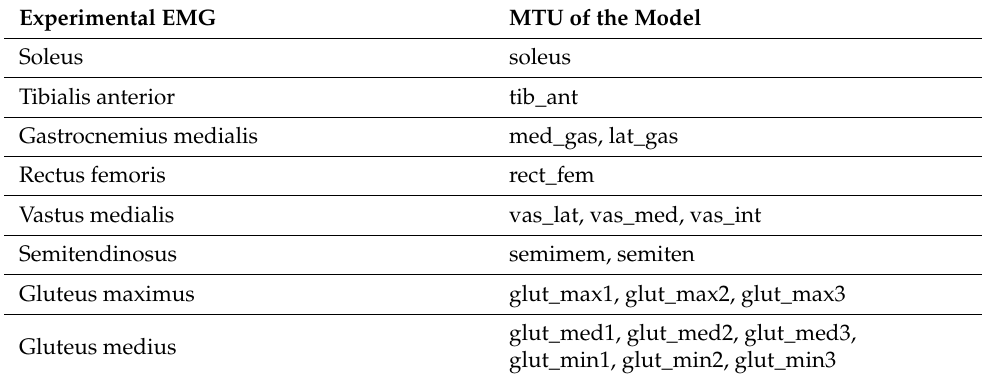
Table 2. The recorded EMG and the MTU driven by the corresponding recorded EMG. MTU of the model depicted was abbreviated as in